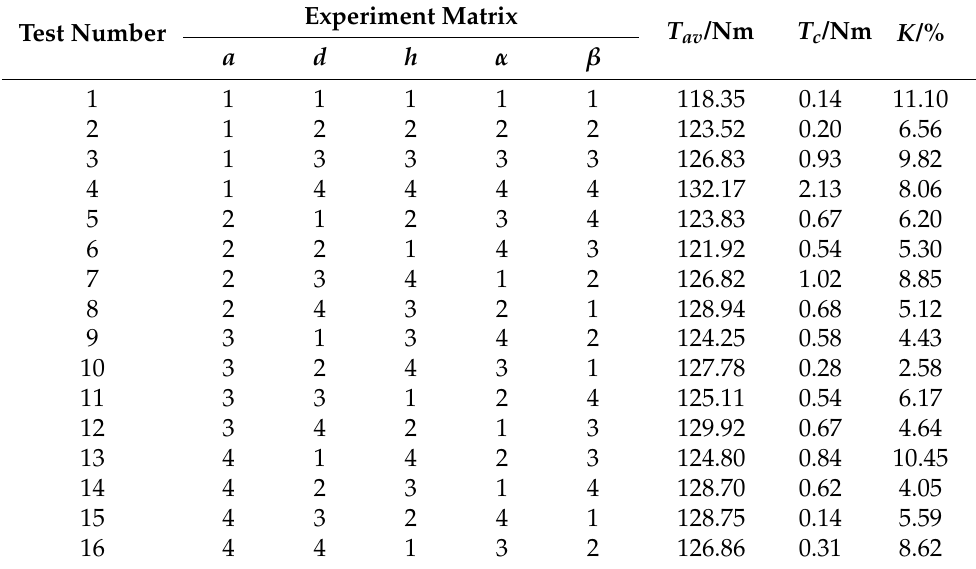
Table 7. Orthogonal table and finite element simulation results.